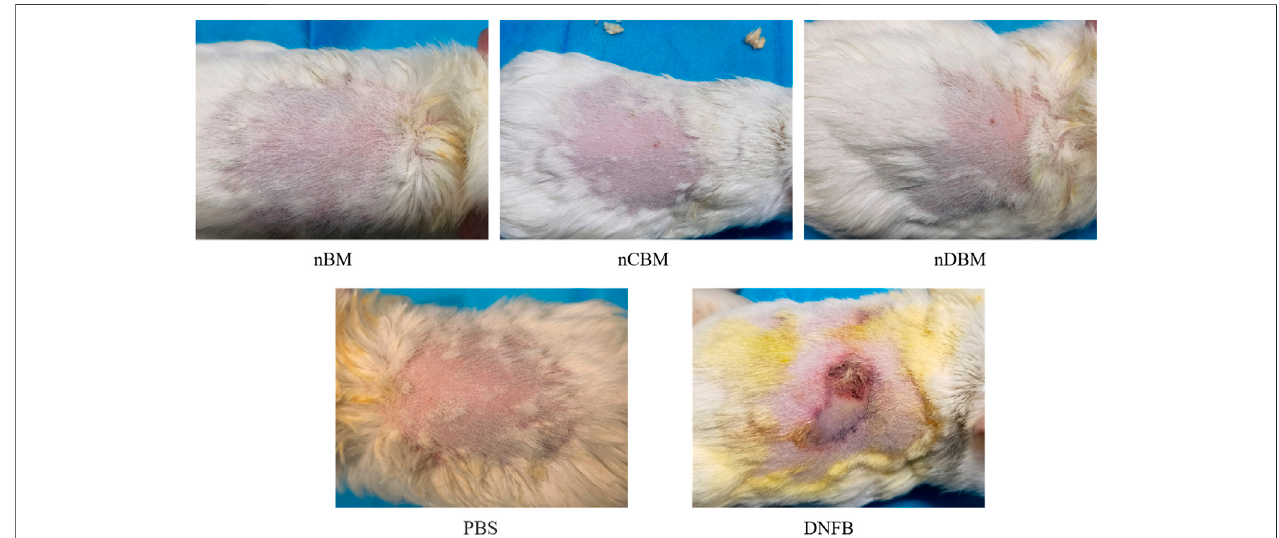
FIGURE 7 | Appearance of the guinea pig skin on the 3rd day of the experiment.